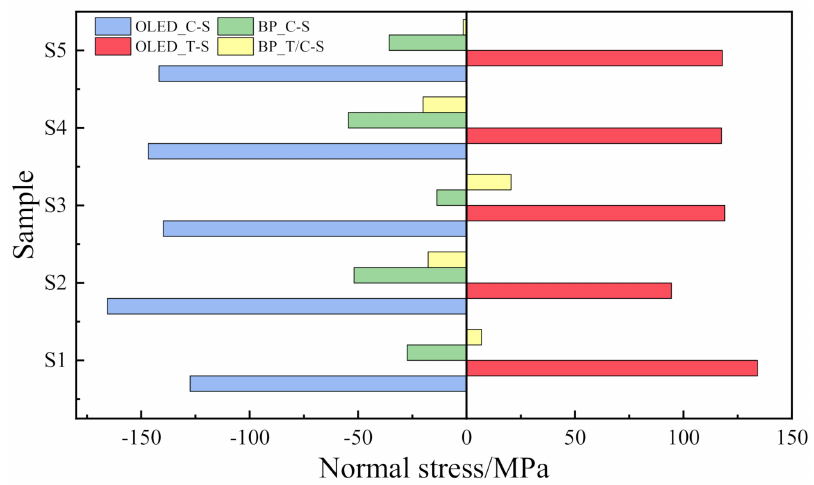
Figure 9. Contrast of normal stress in bending of the central axis with different thickness